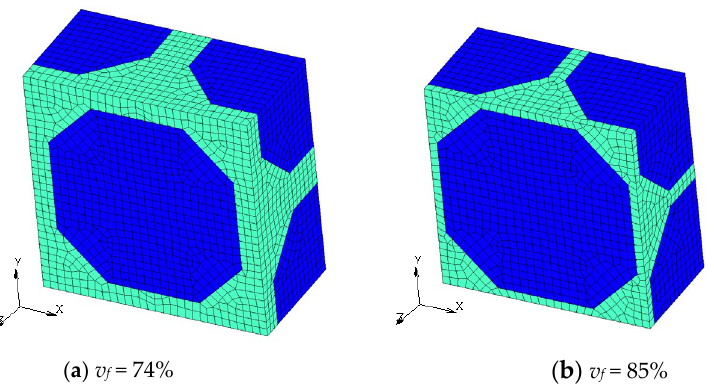
Figure 7. Numerical models of microstructures with Wigner-Seitz cells with different v f .